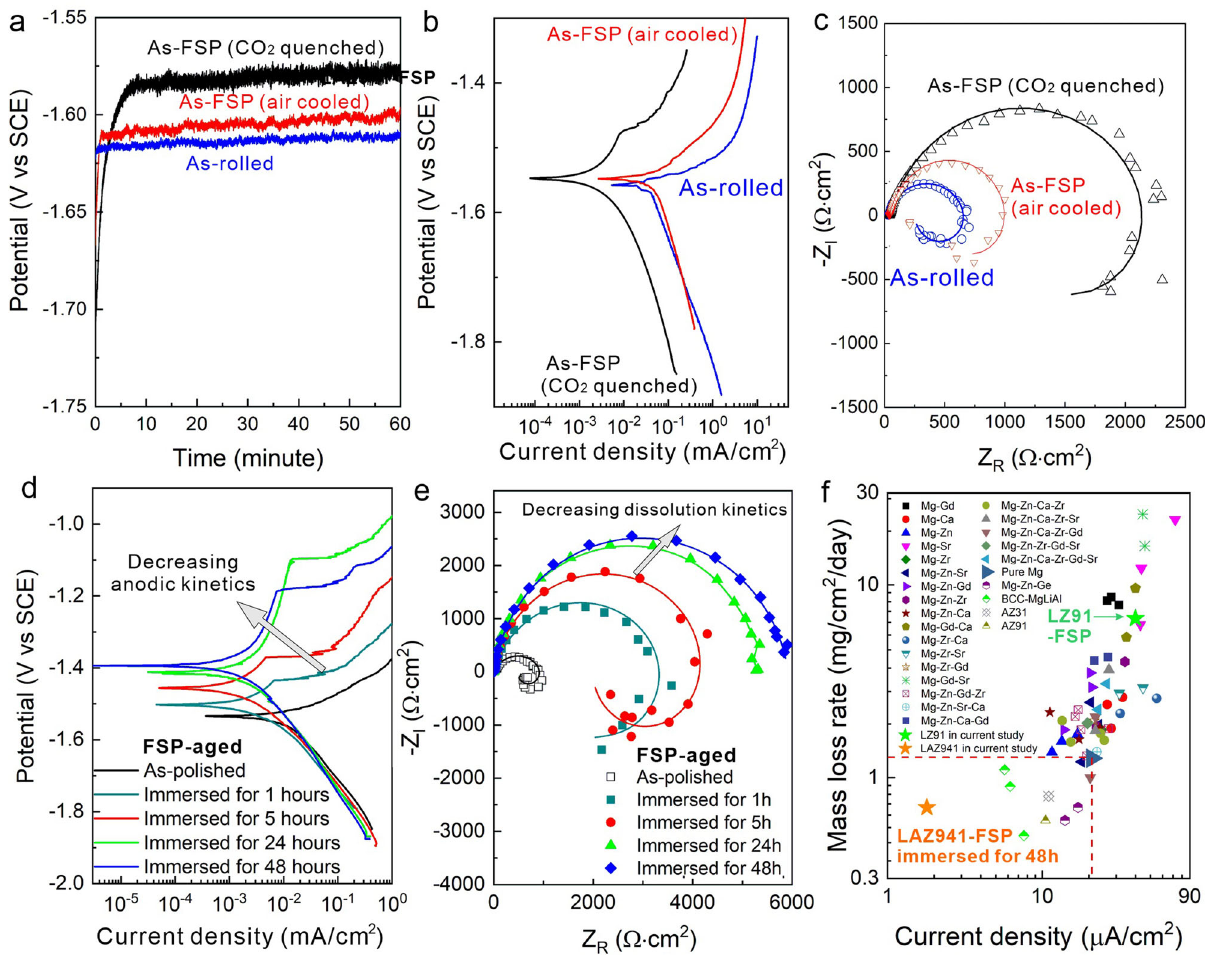
Fig. 1 Measurement of electrochemical durability. Electrochemical tests showing ( a ) open-circuit potential, ( b ) potentiodynamic polarisation curves, and ( c ) EIS Nyquist plots of as-rolled and as-FSP-samples after 1-h immersion in 0.1 M NaCl solution. d , e potentiodynamic polarisation and EIS results of FSP- aged samples (FSP and CO 2 quenched followed by naturally-aged for 2 years) during immersion. f Comparison of mass-loss rate and corrosion current density of FSP-LAZ941 alloy with some typical Mg alloys 11,24 – 26 , including Mg – 11Li – 3Al alloy 11 , and corrosion-resistant Mg – Zn – Ge alloys 24 . Red dashed lines in ( f ) showing the mass-loss rate and corrosion current density of pure Mg 25 as a